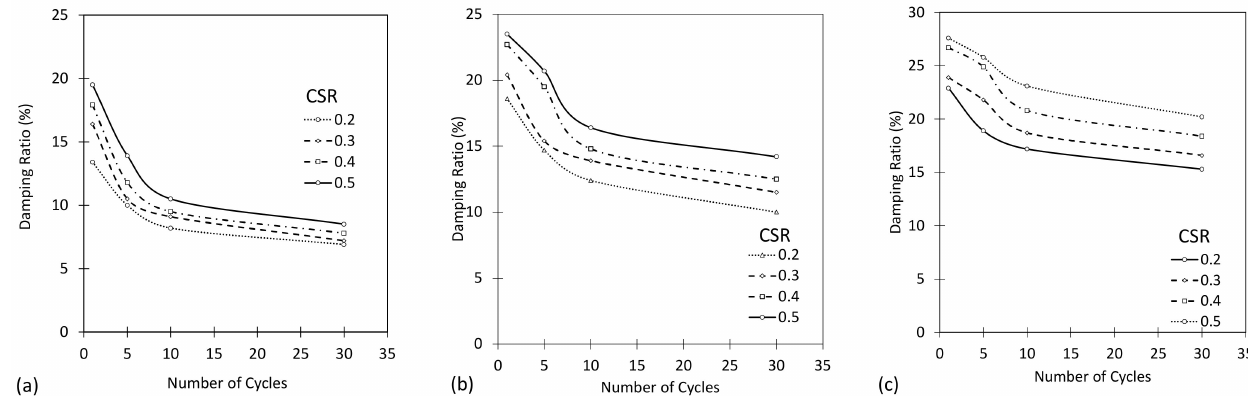
Figure 10. Effects of increasing number of loading cycles on the damping ratio for different CSR conditions and vertical stresses of ( a ) 50 kPa, ( b ) 150 kPa and ( c ) 250 kPa for the fifth